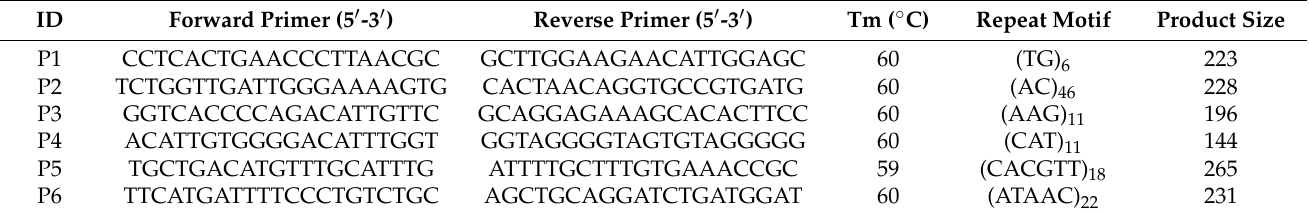
Table 6. The messages of 6 working SSR primer pairs from 10 synthesized